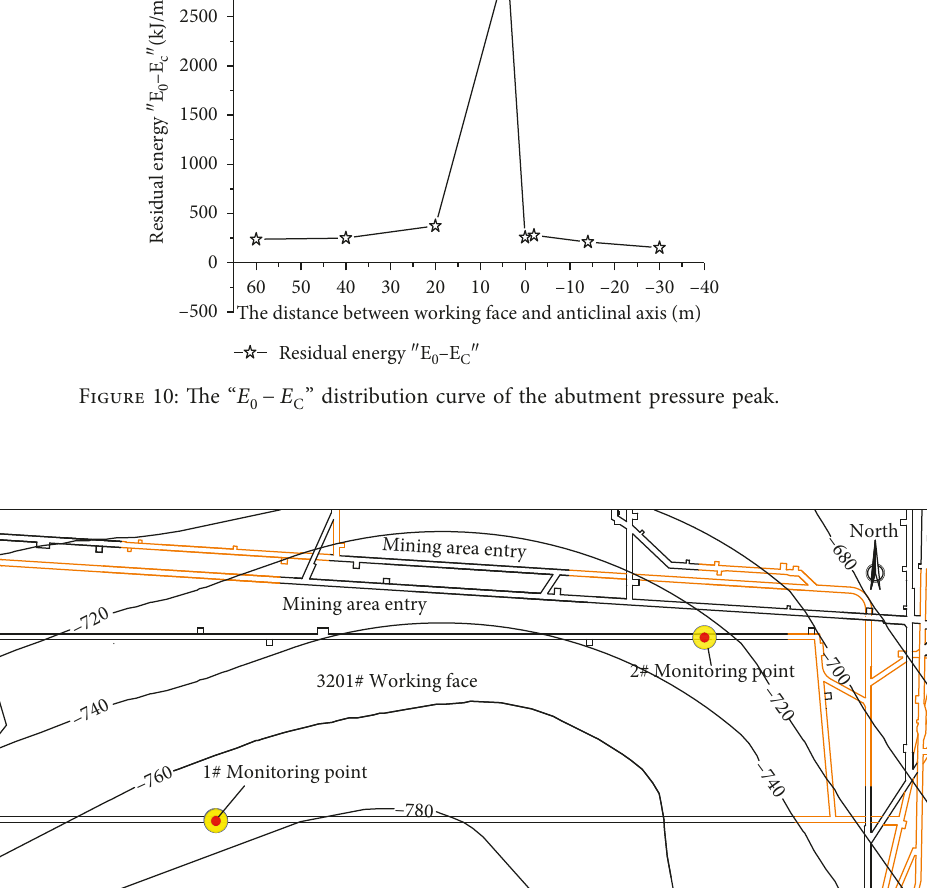
Figure 11: The arrangement diagram of No. 3201 working face microseismic system detector.